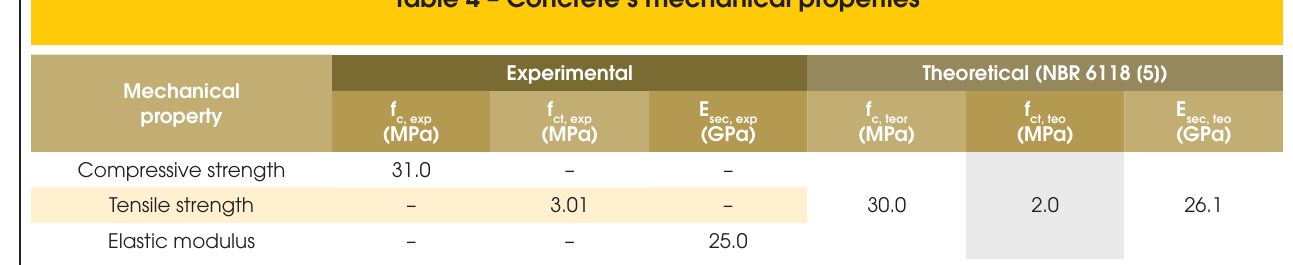
Table 4 – Concrete’s mechanical properties